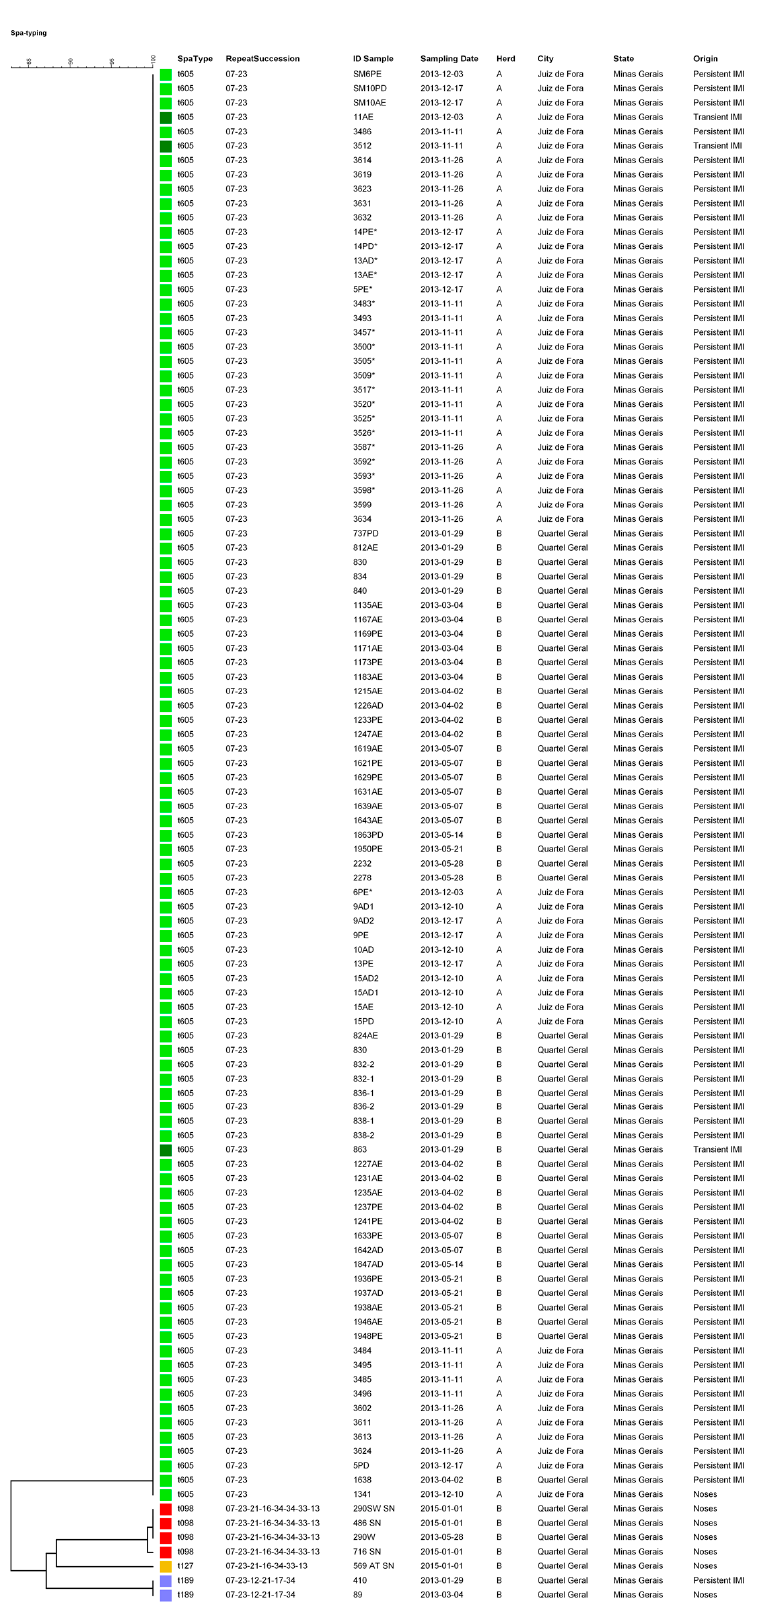
Figure 1. Dendrogram of Staphylococcus aureus strains isolated from milk ( n = 100) and nares / muzzles ( n = 7), discriminated by spa